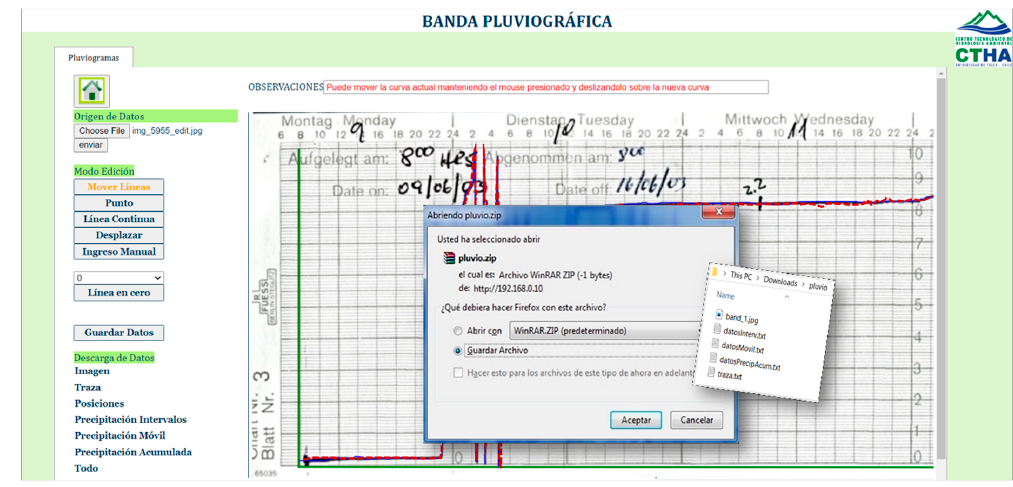
Figure 10. Final file report exported in zipped format and generated output files.